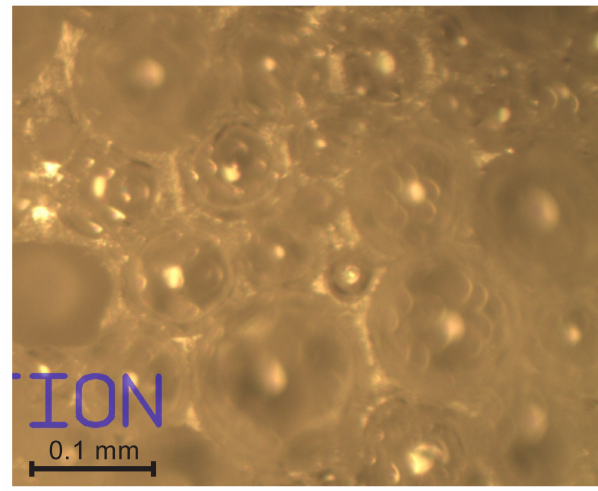
Figure 14. Walls between bubbles of similar dimensions.